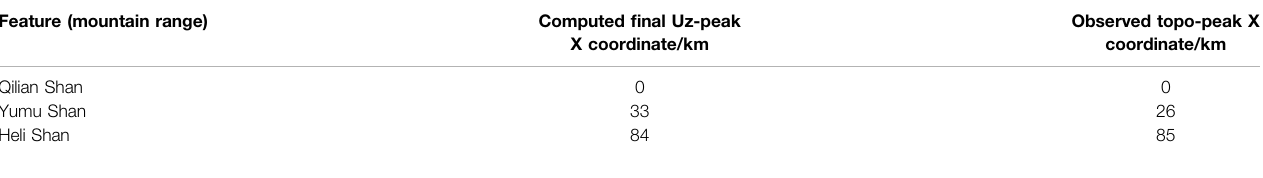
TABLE 4 | Comparison of spatial (horizontal) locations of prominent topographic features: Computed peaks of vertical displacements (after 6.6 km of horizontal shortening) and present-day observed topographicpeaks. For computed topography, horizontalcoordinate has been transformed to fi nal-contracted state. Observed coordinates are as in topographic pro fi le in Figure 1C . Correlation of x-coordinate for QilianShan and HeliShan ranges ’ peaks is almost perfect and that of Yumu Shan range is somewhat off. Feature (mountain